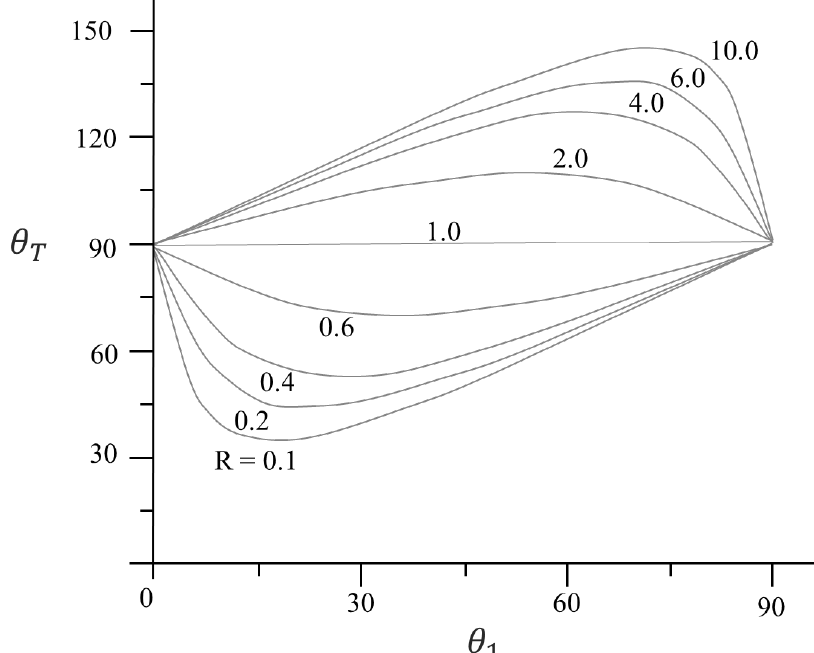
Figure 4. For various impedance ratios, a depiction between a total electrical length and θ 1 for resonant.